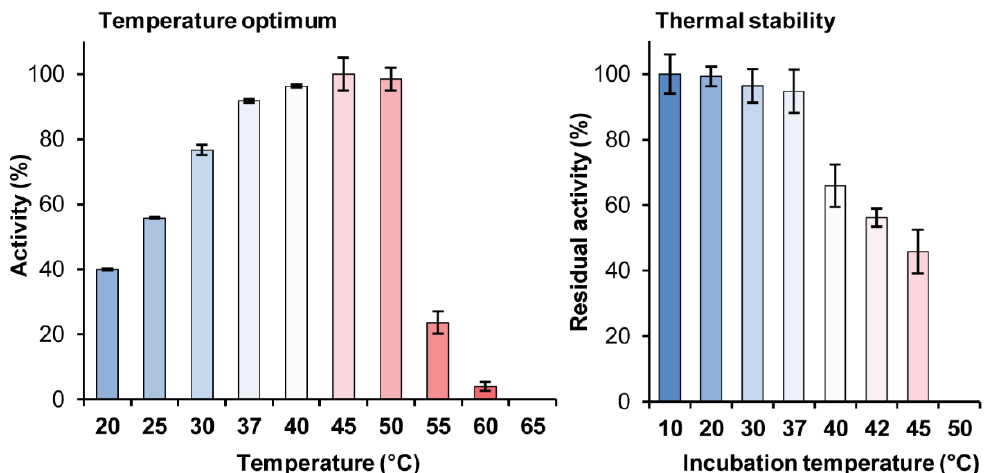
Figure 4. The effect of temperature on activity (left panel) and stability (right panel) of Ba AG2. For the thermostability assay, the enzyme was incubated for 30 min at the indicated temperature and residual activity was determined at 30 °C with p NPG as a substrate (see Materials and Methods, paragraph 4.4. for details). SDs of two to three replicates at each temperature are shown by error bars.